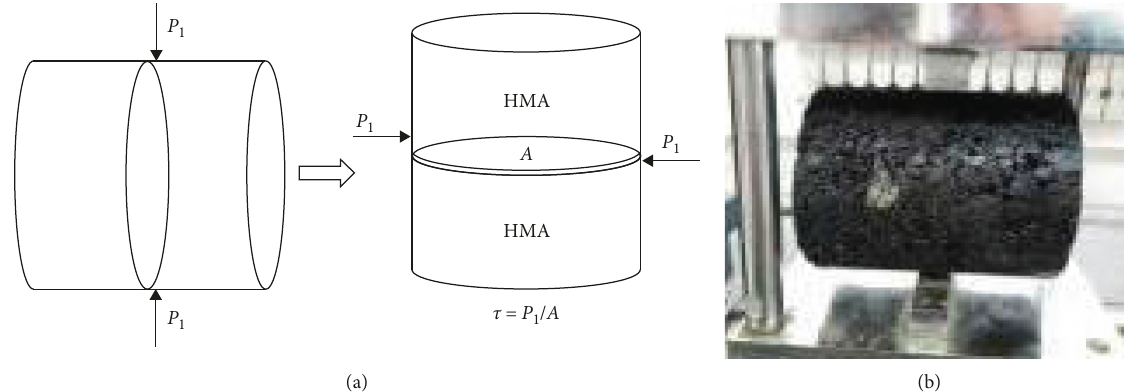
Figure 8: Working state of interlayer adhesion test. (a) Stress diagram of interlayer adhesion test. (b) Working state of interlayer adhesion test.